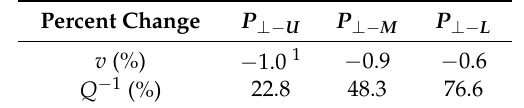
Table 1. The percent change of P-wave velocity and attenuation during stage iii and iv.